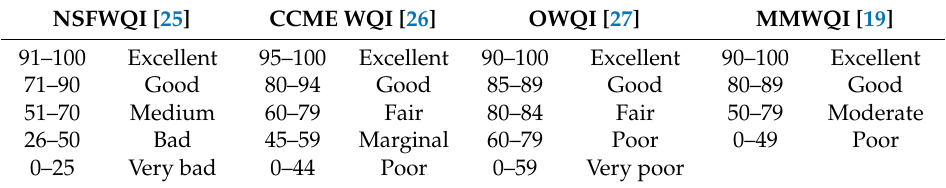
Table 1. Water quality classification according to di ff erent Water Quality Index (WQI)